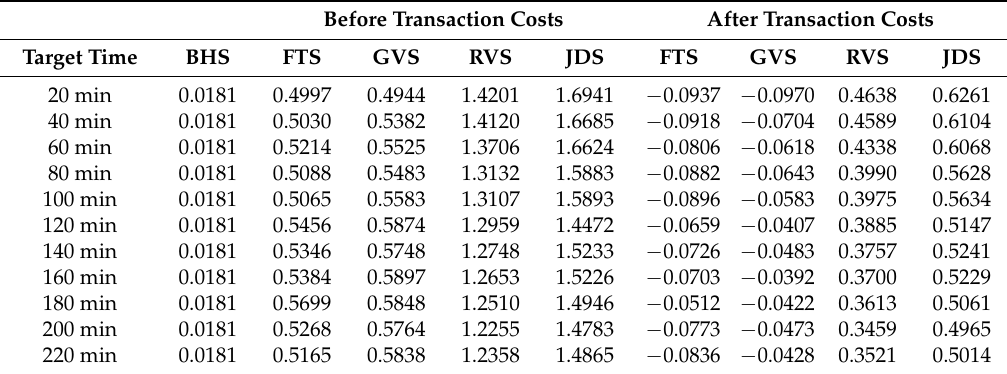
Figure 4. Development of an investment of 1 USD after transaction costs for FTS, GVS, RVS, and JDS (first column) compared to the S&P 500 buy-and-hold-strategy (BHS) (second column). The time period from January 1998–December 2015 is divided into three sub-periods (March 1998/December 2006, January 2007/December 2009, January 2010/December 2015). Table 5. Yearly returns for BHS, FTS, GVS, RVS, and JDS for a varying target time from January 1998–December